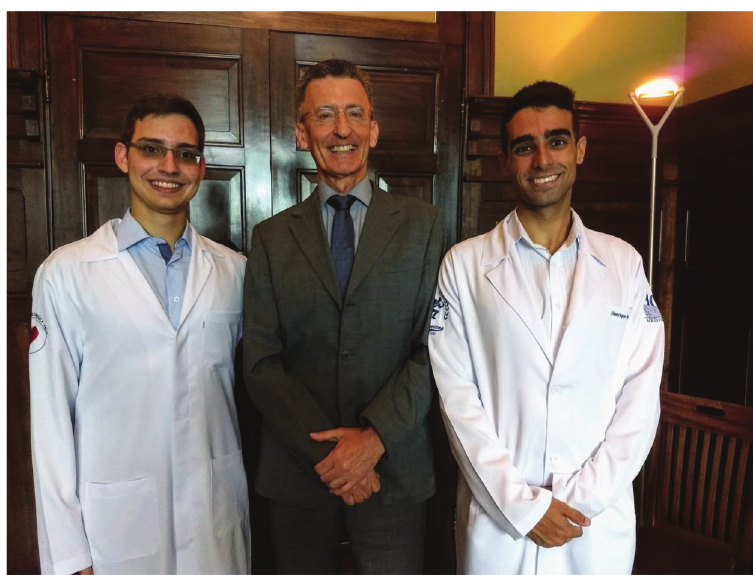
Figure 1 - Gustavo Rosa Gameiro, Professor Jose´ Otavio Costa Auler Jr and Henrique Branzani da Silva ready for the next